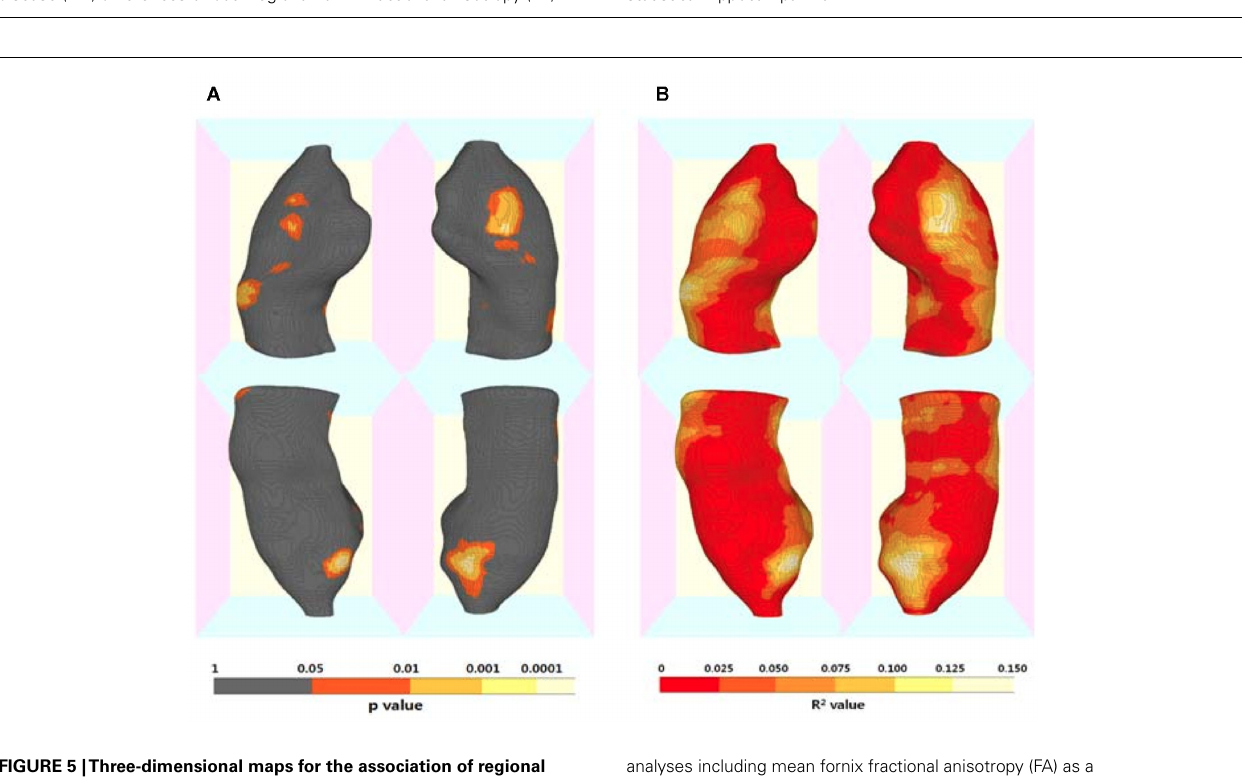
and hippocampal thickness; (B) the statistical fornix ROI with significant CN vs. AD FA differences and p -value map for hippocampal regions associated with mean FA of the statistical fornix ROI; and (C) the statistical hippocampal ROI with significant CN vs. AD thickness differences and p -value map for fornix regions associated with mean thickness of the statistical hippocampal ROI.